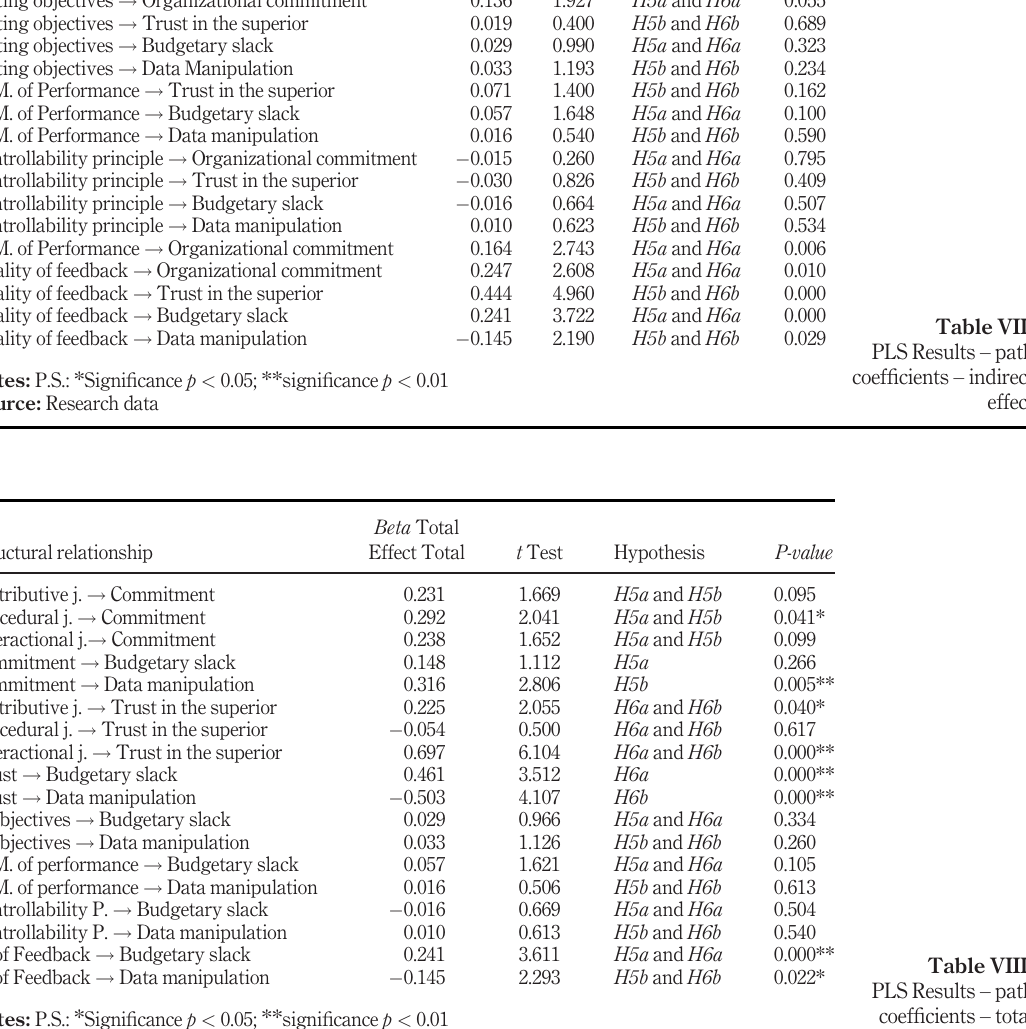
Table VIII. PLS Results –